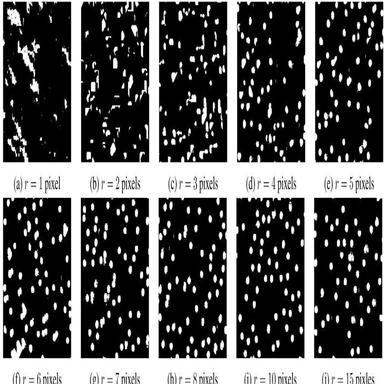
Microstructure reconstruction by using data templates with different radii r.